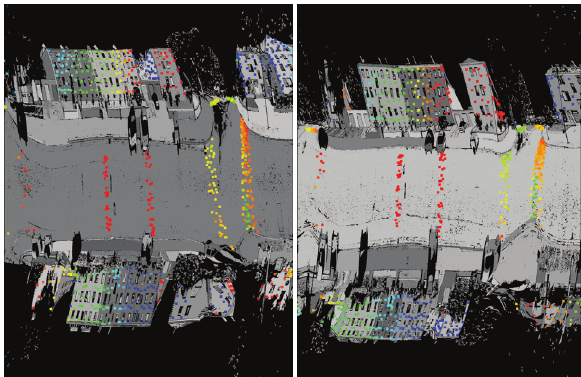
Figure 6. Colour coded deviations between reference and point cloud before adjustment of the trajectory for scanner 1 (left) and scanner 2 (right) with red = +5 cm, green = 0 cm, blue = -5 cm. Histograms of the determined deviations are presented in Fig. 7 for scanner 1 and 2, with a mean value for scanner 1 (2) of 1.1 cm (1.8 cm) and standard deviation of 4.2 cm (4.0 cm), which indicates an overall shift.